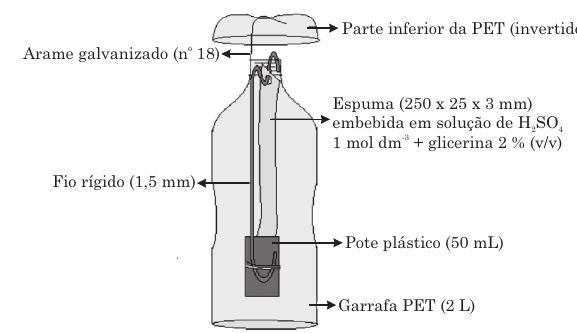
Figura 1. Esquema do sistema coletor de N-NH 3 semiaberto livre estático “Sale”. Fonte: Araújo et al. (2009).